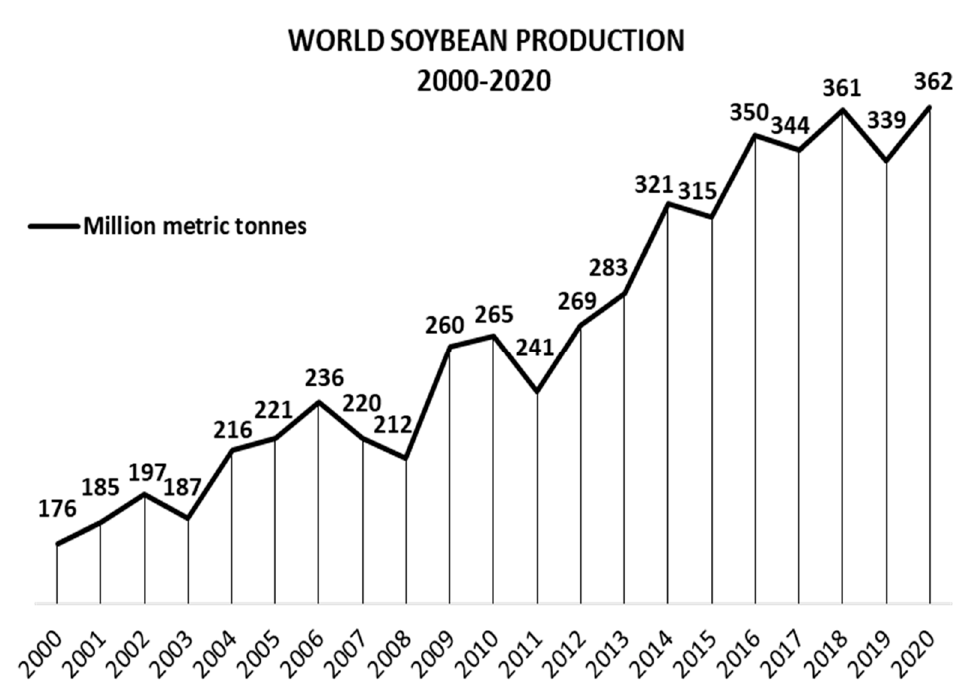
Figure 2. World soybean production 2000–2020, in million metric tons.